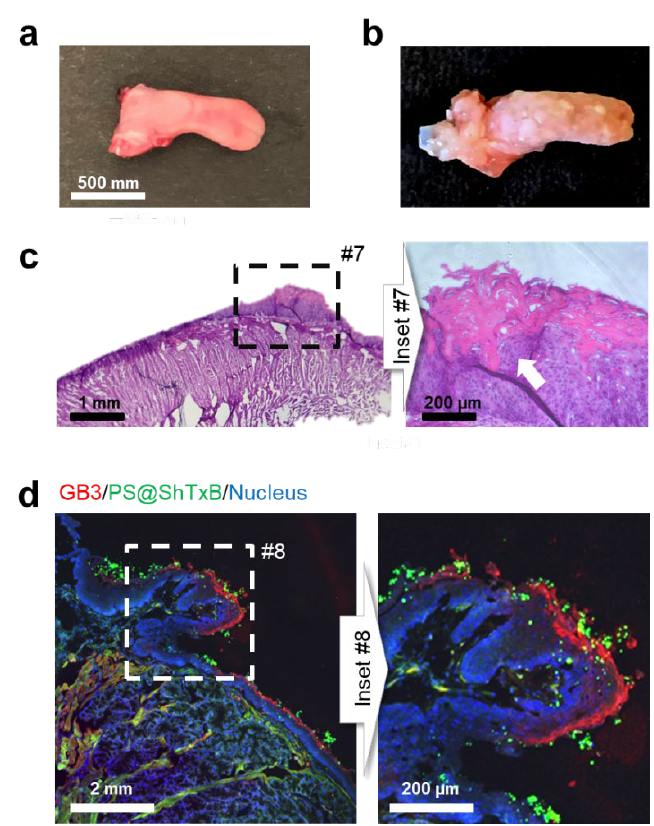
Figure 5. In vivo ShTxB-coated particle targeting. Macroscopic appearance of tongues of control ( a ) and 4NQO-treated mice ( b ). Macroscopic lesions, characteristic of squamous cell carcinoma, are visible on the oral mucosa. Leukoplakia and papilloma-like tumoral masses are distributed throughout the surface of the tongue. ( c ) A hematoxylin-eosin-stained section in a tongue in mice treated with 4NQO where severe dysplasia and an invasive squamous cell carcinoma (inset #7, white arrow) are observed. ( d ) Confocal microscopy image of a cryosection of the affected tissue where a tumoral mass is boxed (inset #8). GB3 receptor immunostaining (red channel) is observed on the surface of the lesions. Upon incubation with the PS@ShTxB (see Figure 2b) particles (green channel) for 10 min, the surface of the GB3-positive lesion is conspicuously coated with the ShTxB-coated nanoparticles. The cell nuclei are visible in the blue channel. These results suggest that this technique can be improved by using different types of nanoparticles to optimize their targeting and thus, be able to selectively apply treatments such as magnetic or optical hyperthermia.